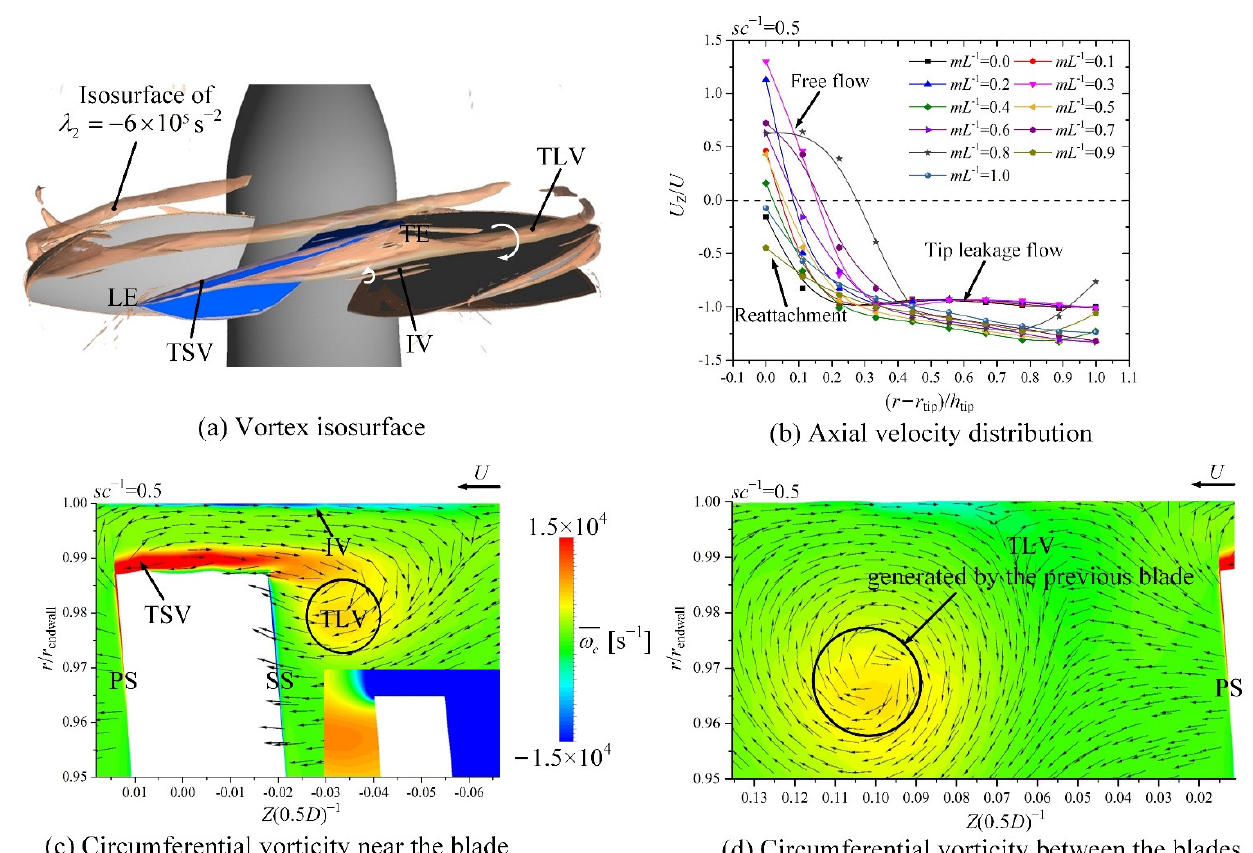
Figure 6. Axial-velocity and vortex-structure distributions in the tip clearance. ( a ) Vortex isosurface; ( b ) Axial velocity distribution; ( c ) Circumferential vorticity near the blade; ( d ) Circumferential vorticity between the blades.